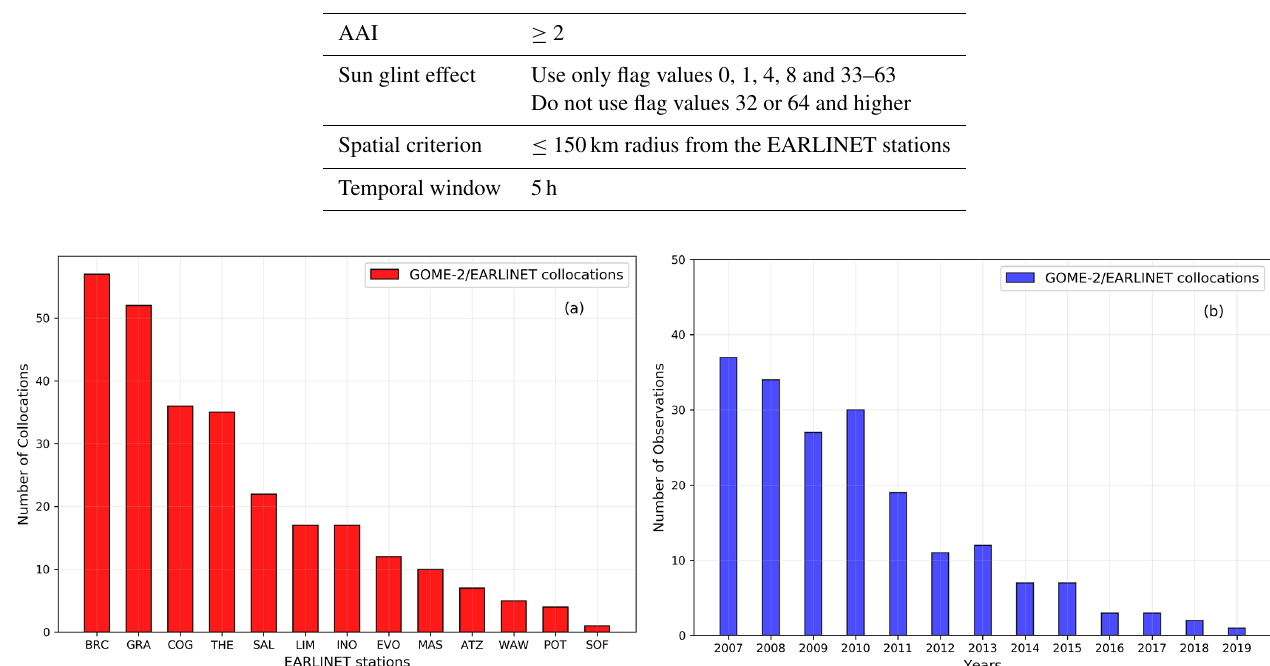
Table 3. List of GOME-2 quality-assurance thresholds applied in the EARLINET comparison.